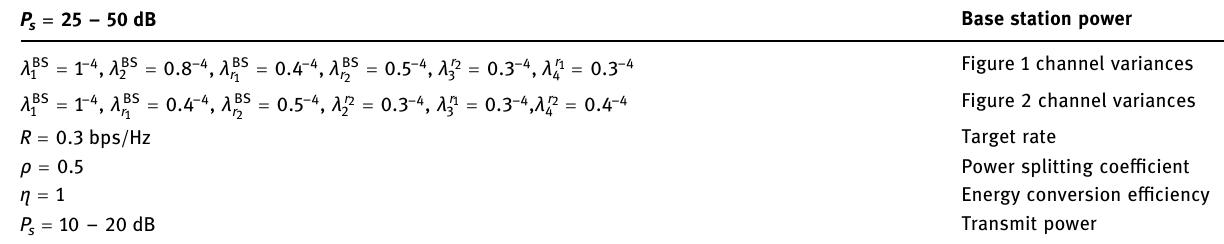
Figure 1 channel variances Figure 2 channel variances